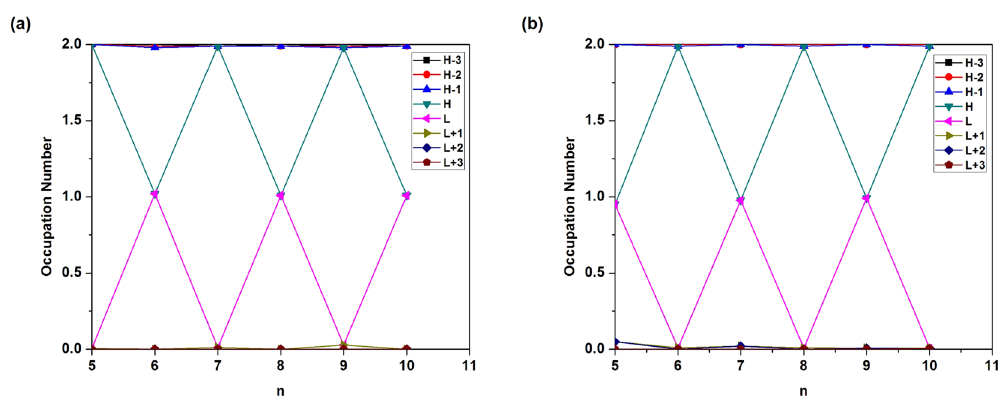
Figure 6. Occupation numbers of the active orbitals (HOMO − 3, HOMO − 2, HOMO − 1, HOMO, LUMO, LUMO + 1, LUMO + 2, and LUMO + 3) for the lowest singlet states of ( a ) C n and ( b ) Li 2 C n , calculated using TAO-BLYP-D. For brevity, HOMO is denoted as H, LUMO is denoted as L, and so